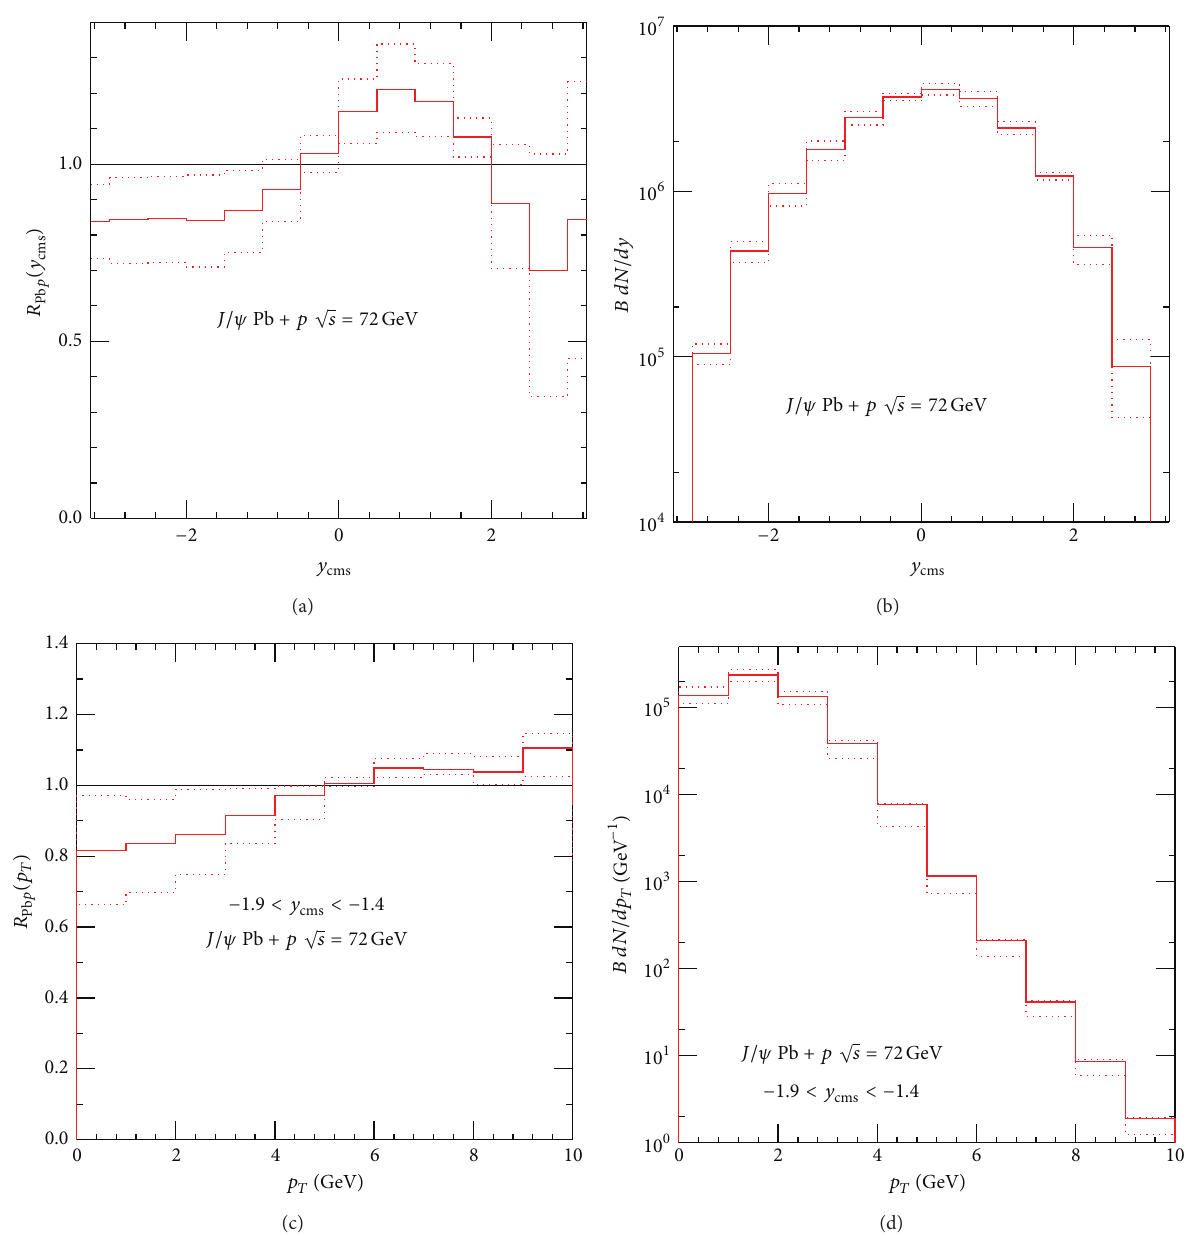
Figure 4: The predicted 𝐽/𝜓 shadowing ratios (a, c) and rates (b, d) as a function of center of mass rapidity (a, b) and 𝑝 𝑇 (c, d) for Pb + 𝑝 collisions at √𝑠 𝑁𝑁 = 72 GeV. The solid curve in each plot is the central EPS09 NLO result, while the dotted curves outline the shadowing uncertainty